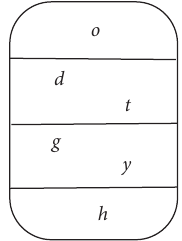
Figure 1: Approximation space ( Q, φ ) .